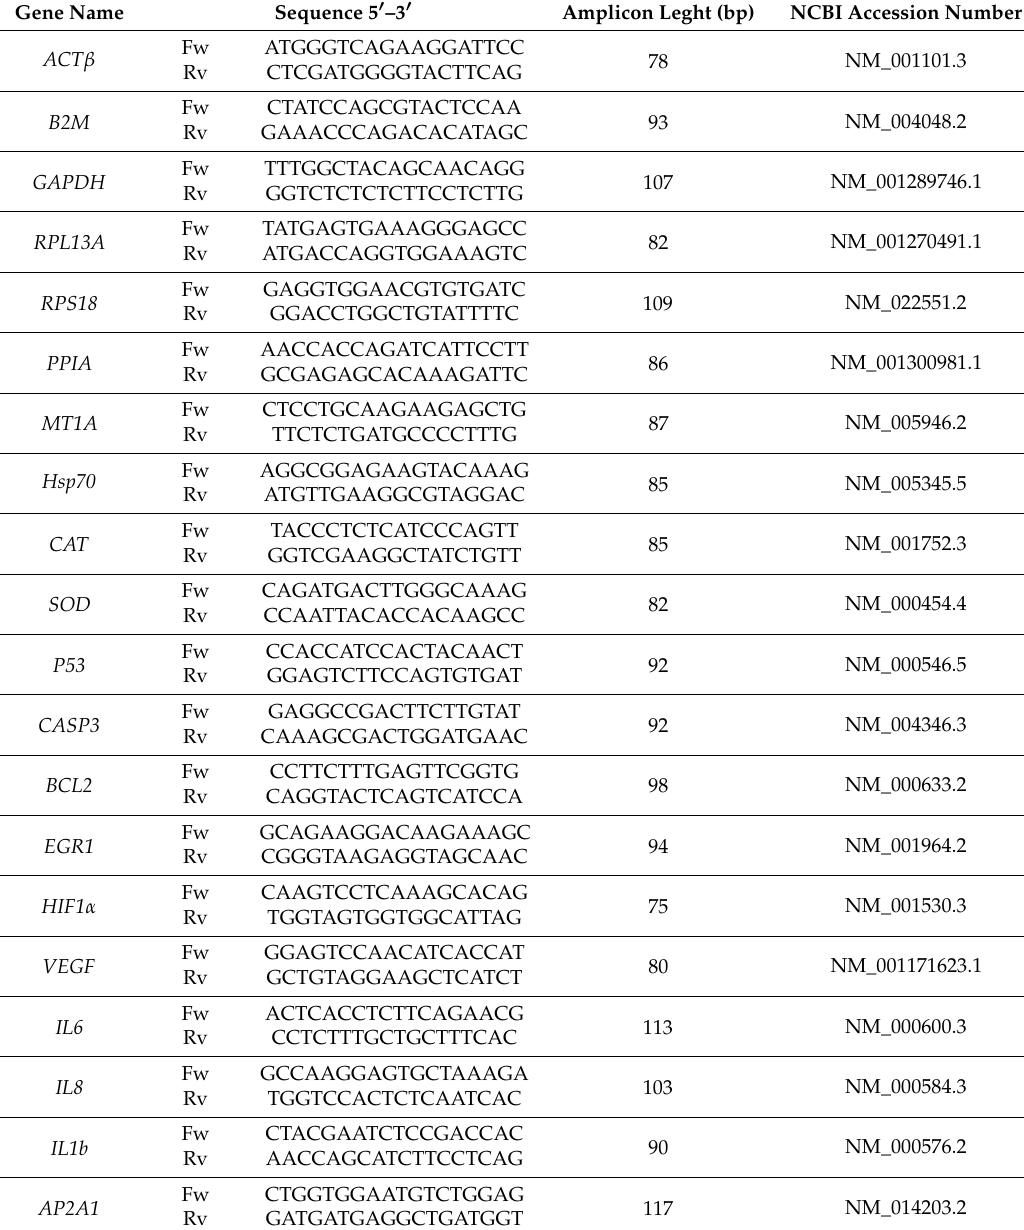
Table 1. Primers used in this work. Fw: forward, Rv: